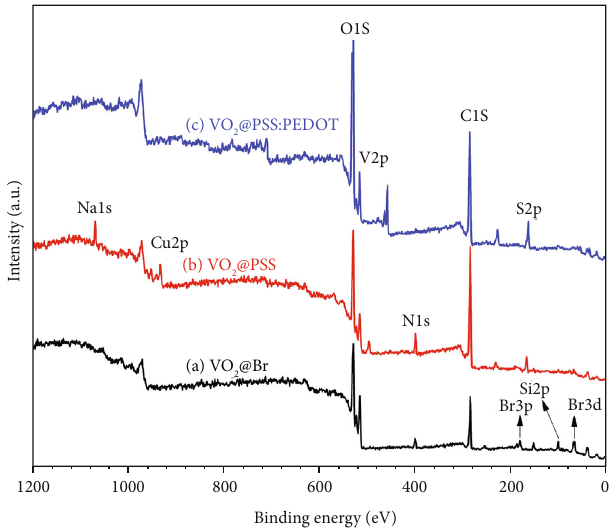
Figure 3: XPS survey spectrum of (a) VO